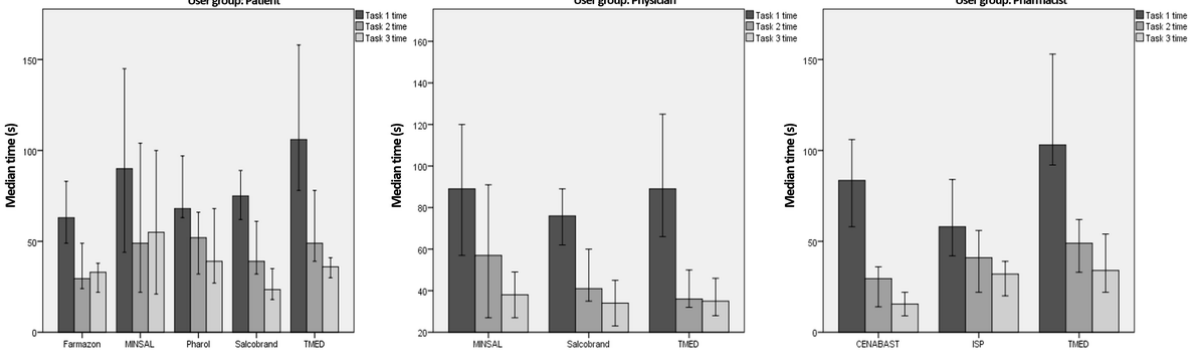
Figure 4. Median task completion times for patients (left), physicians (center), and pharmacists (right). Times per task 1 (dark), task 2 (lighter), and task 3 (lightest) are shown with a 95% CI. CENABAST: National Health Service System of Chile; ISP: Public Health Institute of Chile; MINSAL: Ministry of Health of Chile; TMED: medication